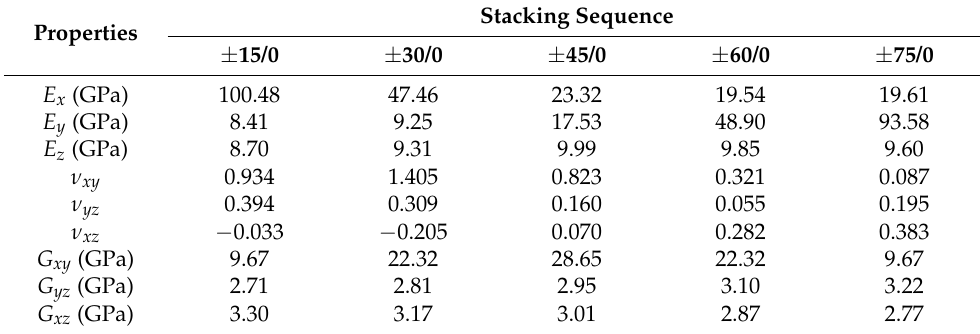
Table 10. Effective engineering constants (three-dimensional laminate theory).